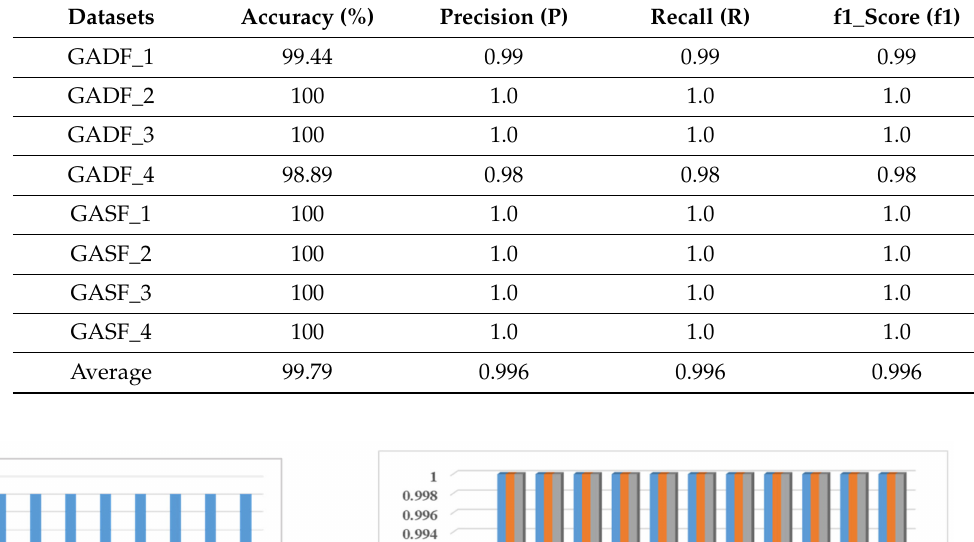
Table 5. The performance measurement of the designed CNN architecture.